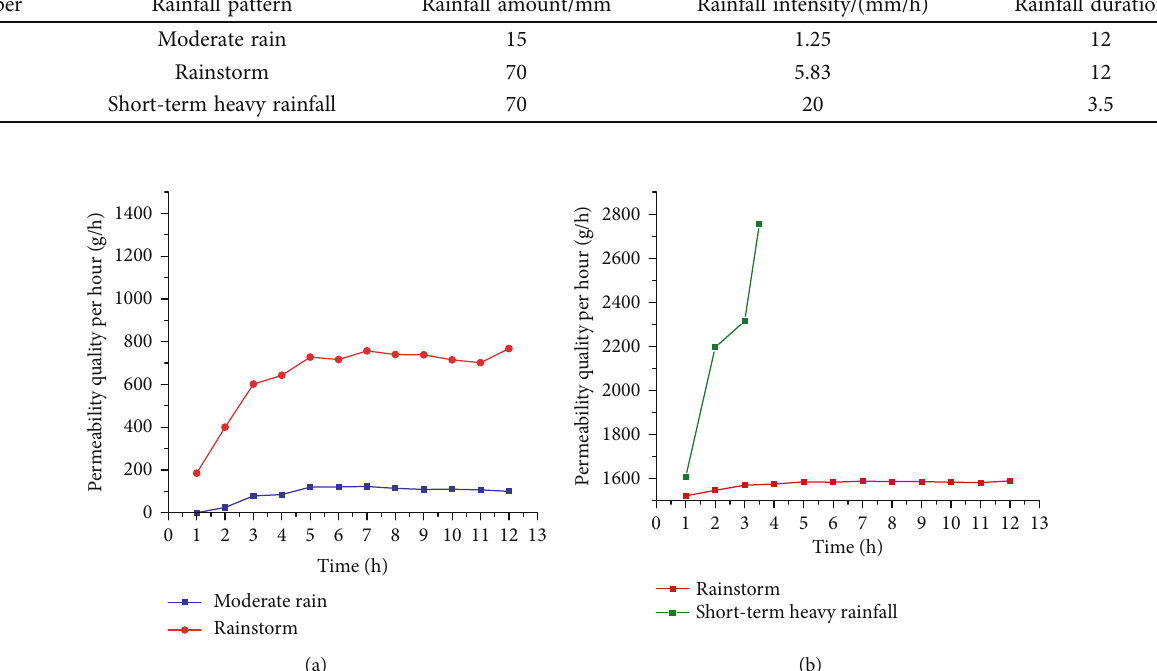
Figure 4: Permeability quality per hour of samples under di ff erent rainfall conditions: (a) permeability quality per hour under di ff erent rainfall intensities with the same rainfall duration; (b) permeability quality per hour under di ff erent rainfall intensities with the same rainfall amount.